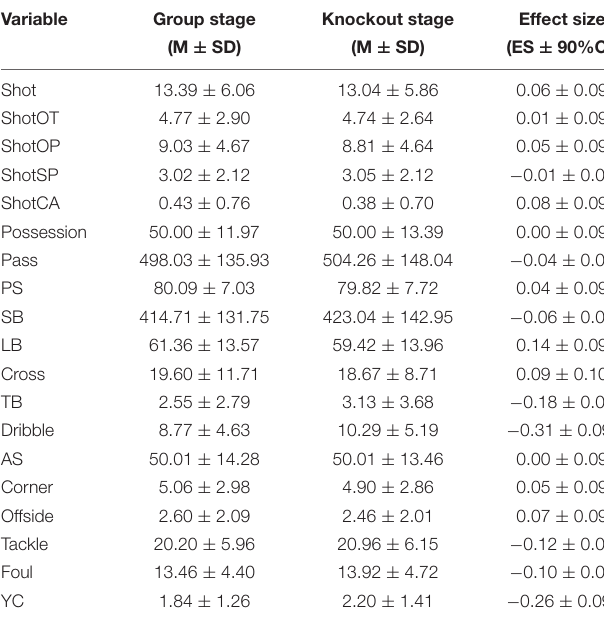
TABLE 1 | Comparison of teams’ technical match statistics between group stage and knockout stage in the UEFA Champions